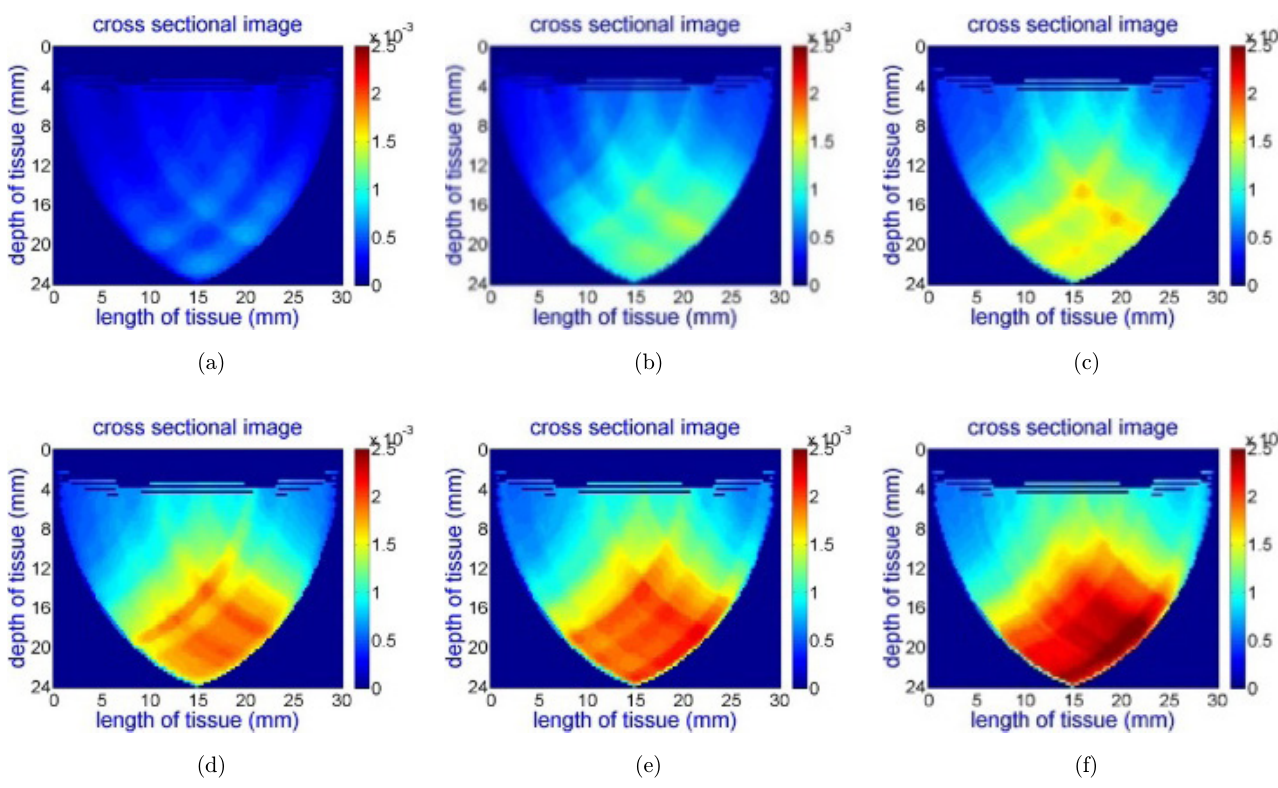
Fig. 9. Reconstructed images for the wavelength of 690 nm while concentration of India black ink is gradually increased. (a)